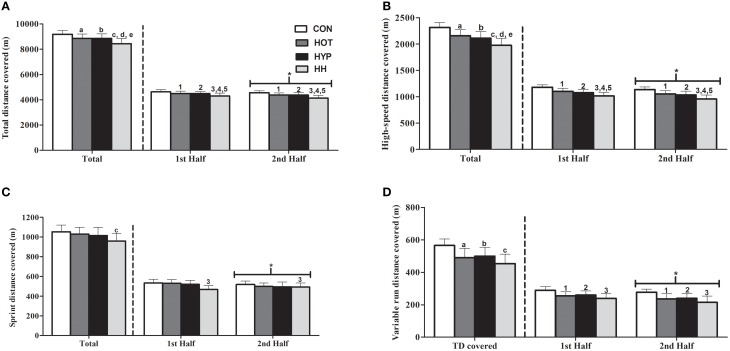
The total distance covered (A), high-speed distance covered (B) variable run distance covered (C) and sprint distance covered (D) in total and in each half at CON, HOT, HYP, and HH. Total, high-speed and variable run distance covered were significantly reduced (p < 0.05) in both halves of HOT and HYP compared with CON. These decrements for total and high-speed distance covered were exacerbated in HH compared with HOT and HYP. Sprint distance was significantly reduced (p < 0.05) in both halves of HH compared with CON. *Significant difference from the first half;aSignificant difference between CON and HOT (p < 0.05); bSignificant difference between CON and HYP (p < 0.05); cSignificant difference between CON and HH (p < 0.05); dSignificant difference between HOT and HH (p < 0.05); eSignificant difference between HYP and HH (p < 0.05);1Significant difference between halves in CON and HOT; 2Significant difference between halves in CON and HYP; 3Significant difference between halves in CON and HH 4Significant difference between halves in HOT and HH; 5Significant between halves in HYP and HH.